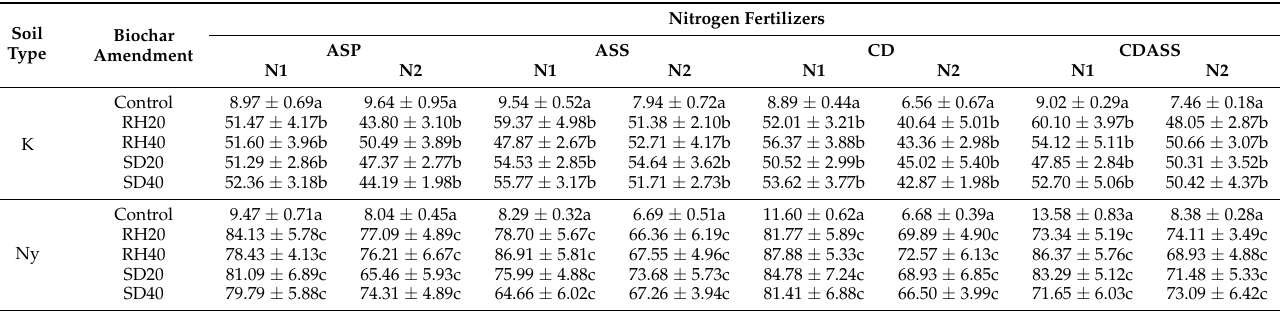
Table 4. Nitrogen uptake in